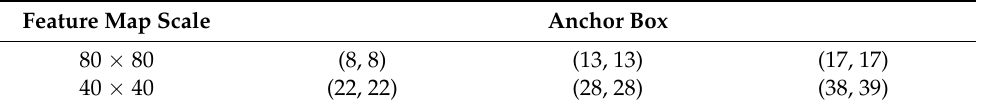
Table 1. Anchor box size allocation.